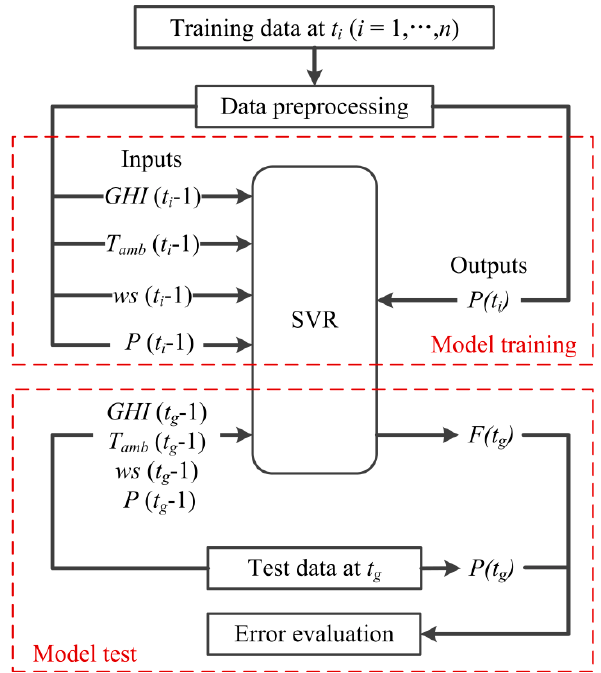
Figure 11. The framework of support vector regression (SVR) benchmark model.